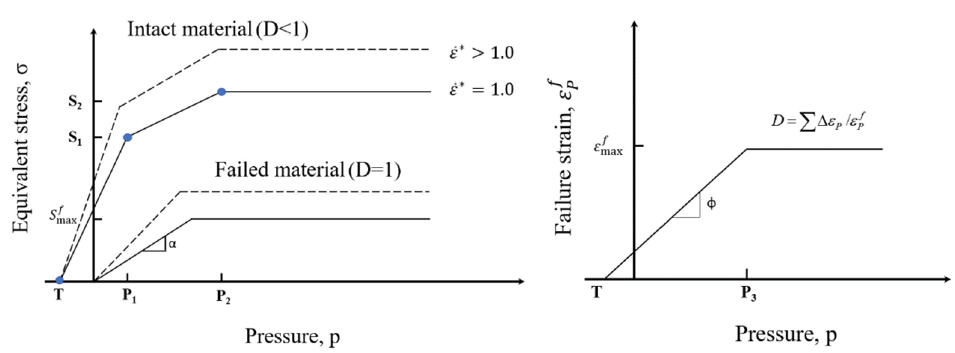
Figure 3. Description of the Johnson–Holmquist-1(JH-1) constitutive model for ceramics. Table 1. JH-1 material model constants for SiC [28].